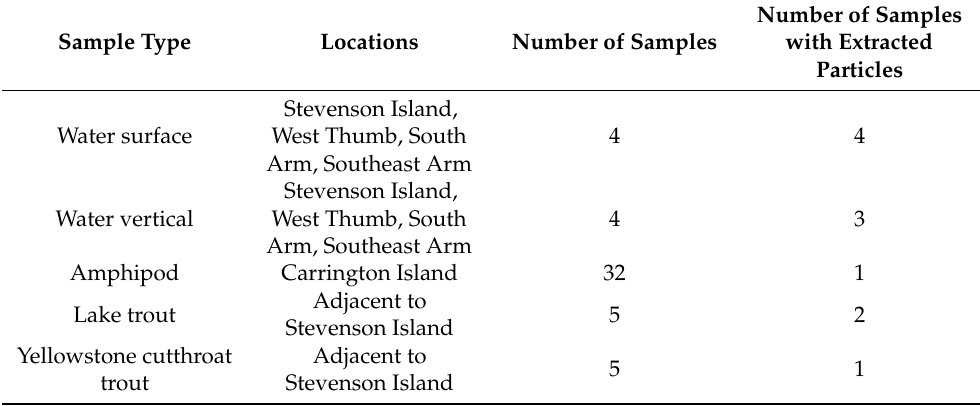
Table 1. Number of samples, and samples with extracted particles by sample type and location, collected during 2019 in Yellowstone Lake, Yellowstone National Park, Wyoming, USA. For water and amphipod sampling locations refer to Figure